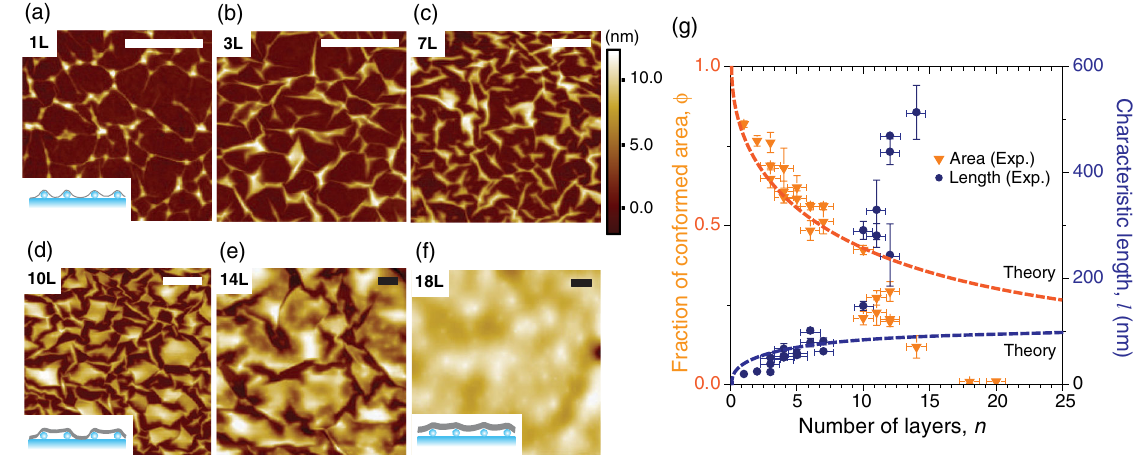
FIG. 6. Typical AFM images of (a) monolayer, (b) trilayer, (c) 7-layer, (d) 10-layer, (e) 14-layer, and (f) 18-layer graphene on SiO with nanoparticle density 160 (cid:5) 24 (cid:3) m (cid:3) 2 . The scale bar in each image is 400 nm. The insets in (a), (d), and (f) are corresponding schematics of graphene films on nanoparticles to the AFM images. (g) The fractional area (cid:12) where graphene conforms to the substrate and the characteristic length l of the delaminated domains, as functions of the number n of graphene layers. The dashed curves are the theoretical expectations for (cid:12) (orange) and l (blue) (described in text).